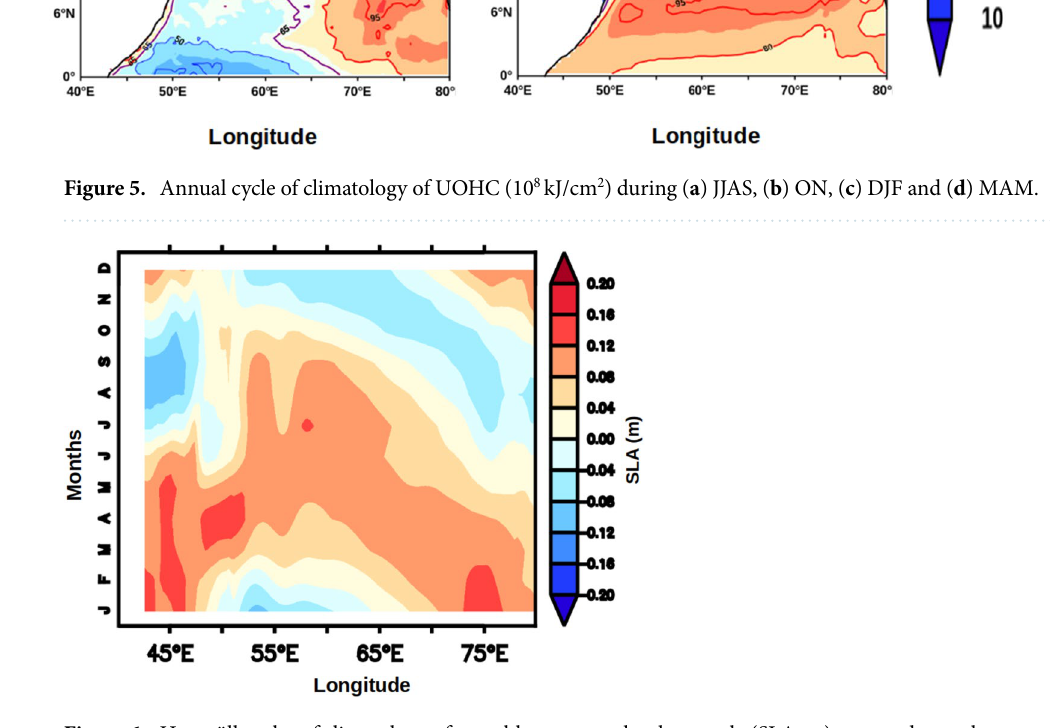
Figure 6. Hovmöller plot of climatology of monthly mean sea level anomaly (SLA, m) averaged over the latitudes from 4°N to 12°N in the Arabian